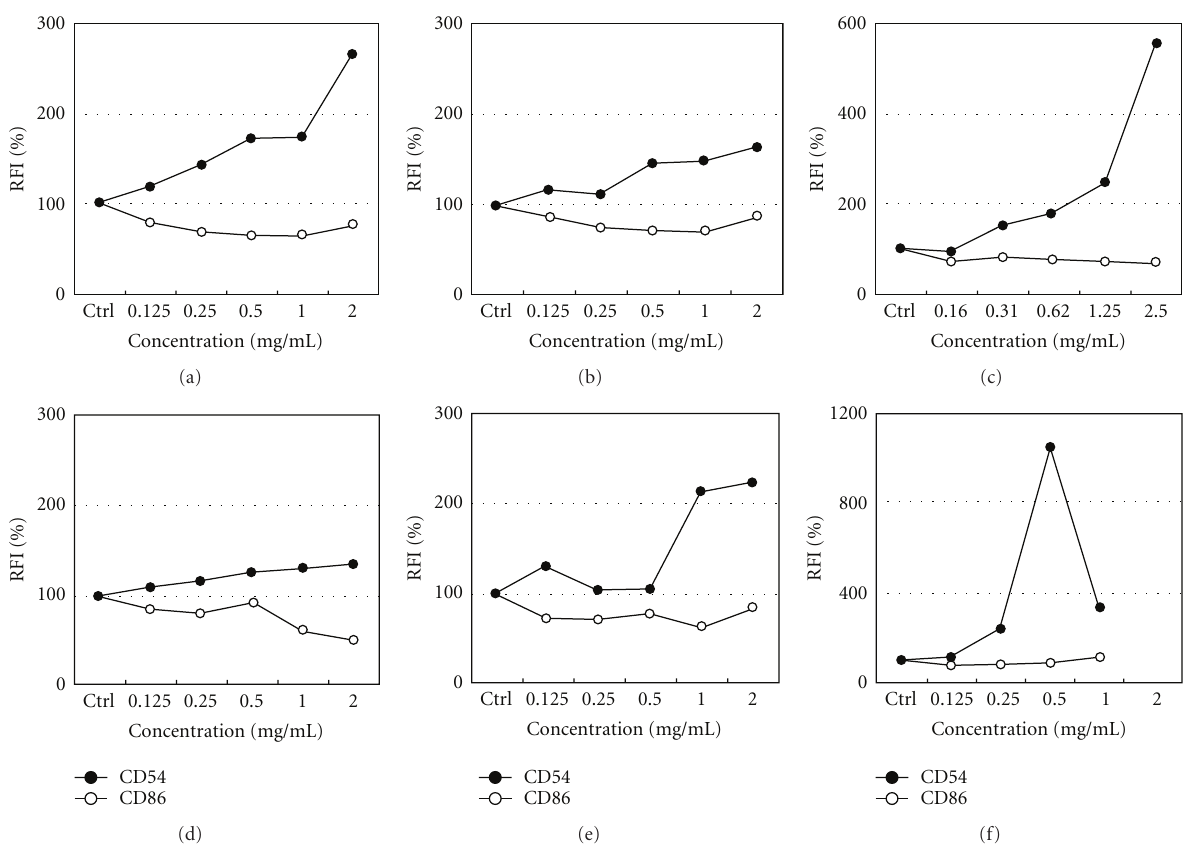
Figure 3: RFI results for each biodegradable polymers. Only living cells were selected by using PI dye. Next, we displayed living cells as FITC histograms, and then we showed the power of the Geom mean. RFI (%) was calculated from Geom mean as described in test. (a) P1, (b) P2, (c) P3, (d) P4, (e) P5, and (f) P6, N.T.: not